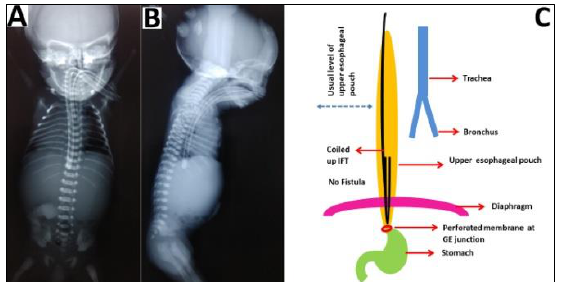
Figure 3: A, B) Radiographs with red rubber catheter in situ (AP and lateral views; A and B) showing presence of obstruction